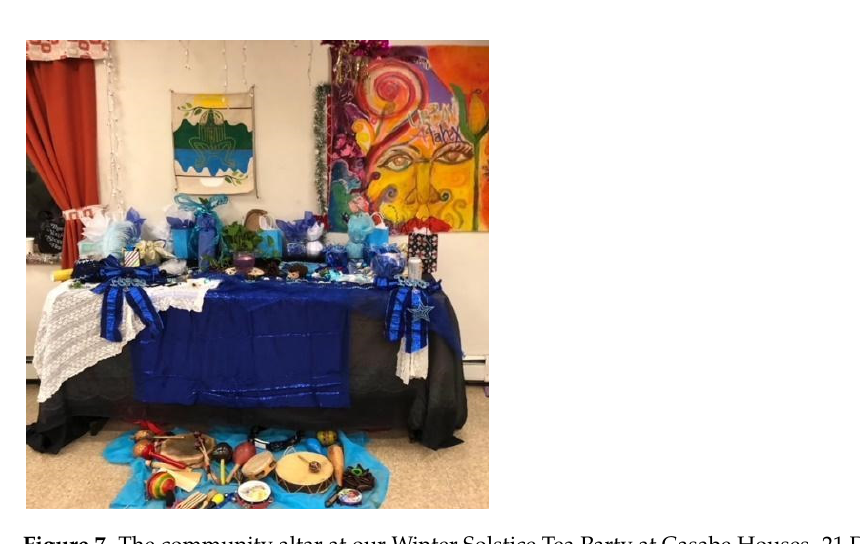
Figure 6. Community gathers at the river at Riverside Park, New York for a Summer Solstice Celebration to welcome in the new season. 20 June 2020.